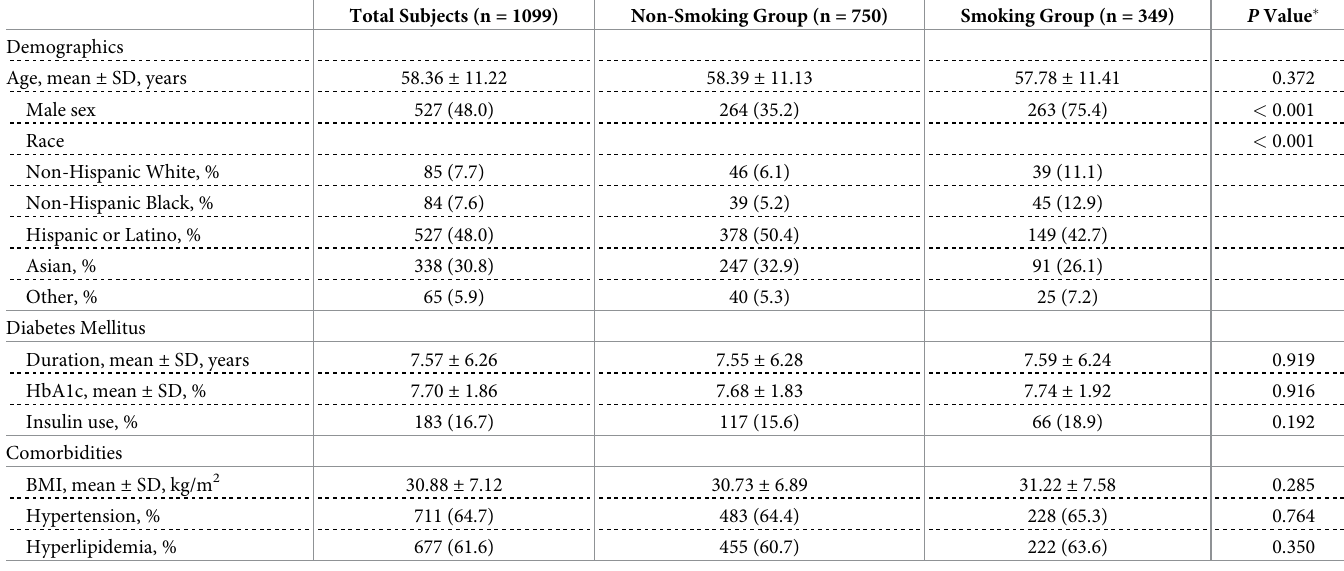
Table 1. Demographic and clinical characteristics stratified by smoking